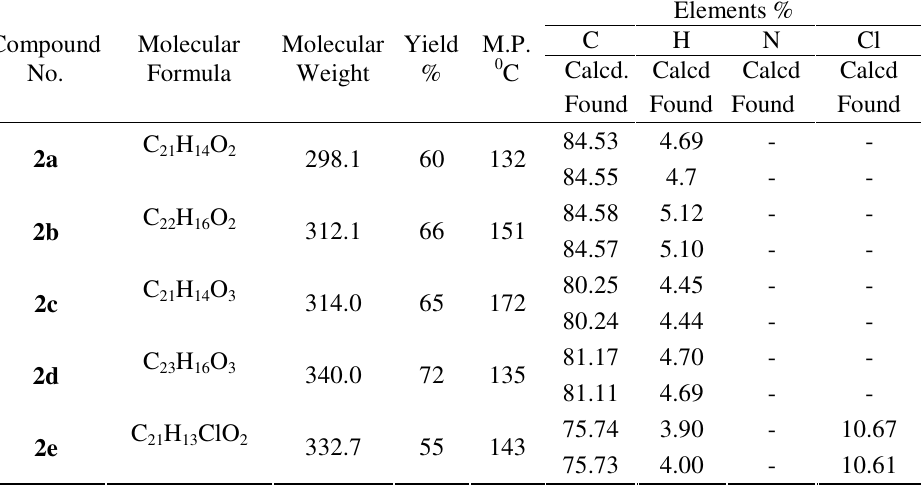
Table 1. Physical data of the synthesized